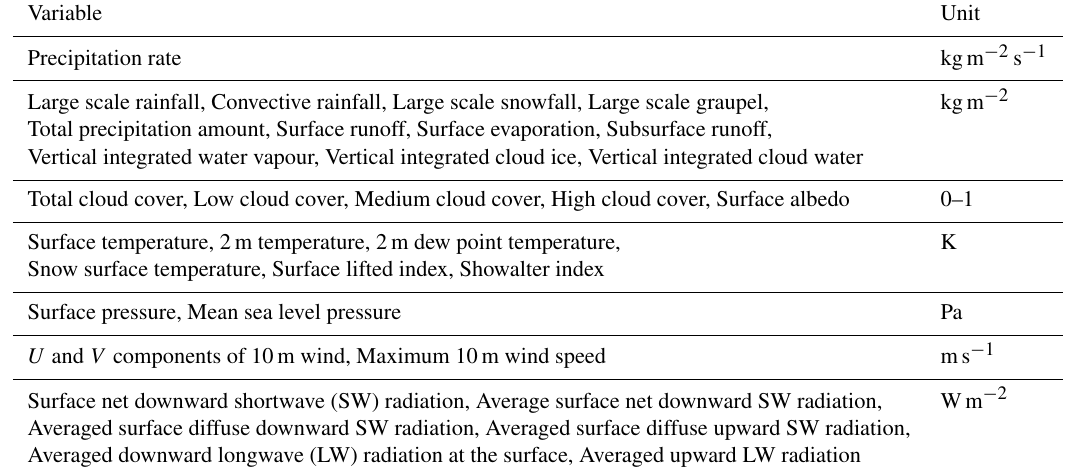
Table 3. COSMO-CLM surface or near-surface parameters (with units) archived by ICHEC at 1h intervals. Variable